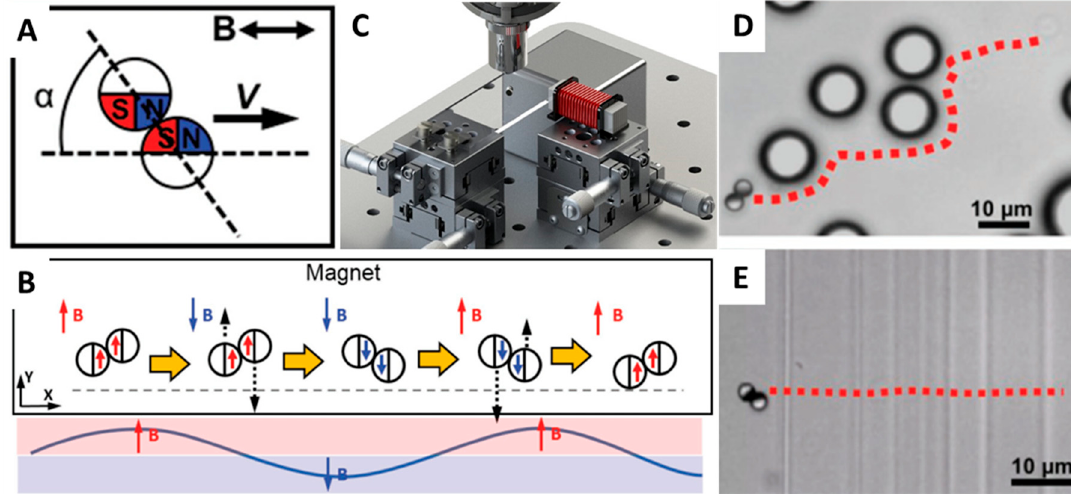
Figure 7. ( A ) When exposed to a magnetic field, the dimer immediately aligns its major axis with the field direction at an angle α of 47.6 ± 2.6°, determined by the dimer geometry. ( B ) Schematic showing the propulsion mechanism of microdimer surface walkers under an oscillating magnetic field. ( C ) Schematic of the experimental setup in which a magnetic dimer moves along the magnetic field direction, away from the magnet. ( D ) A microdimer surface walker bypasses several polystyrene microspheres. ( E ) A microdimer surface walker crosses continuous cracks on a glass surface. Adapted with permission from Reference [83], copyright Advanced Functional Materials 2018.